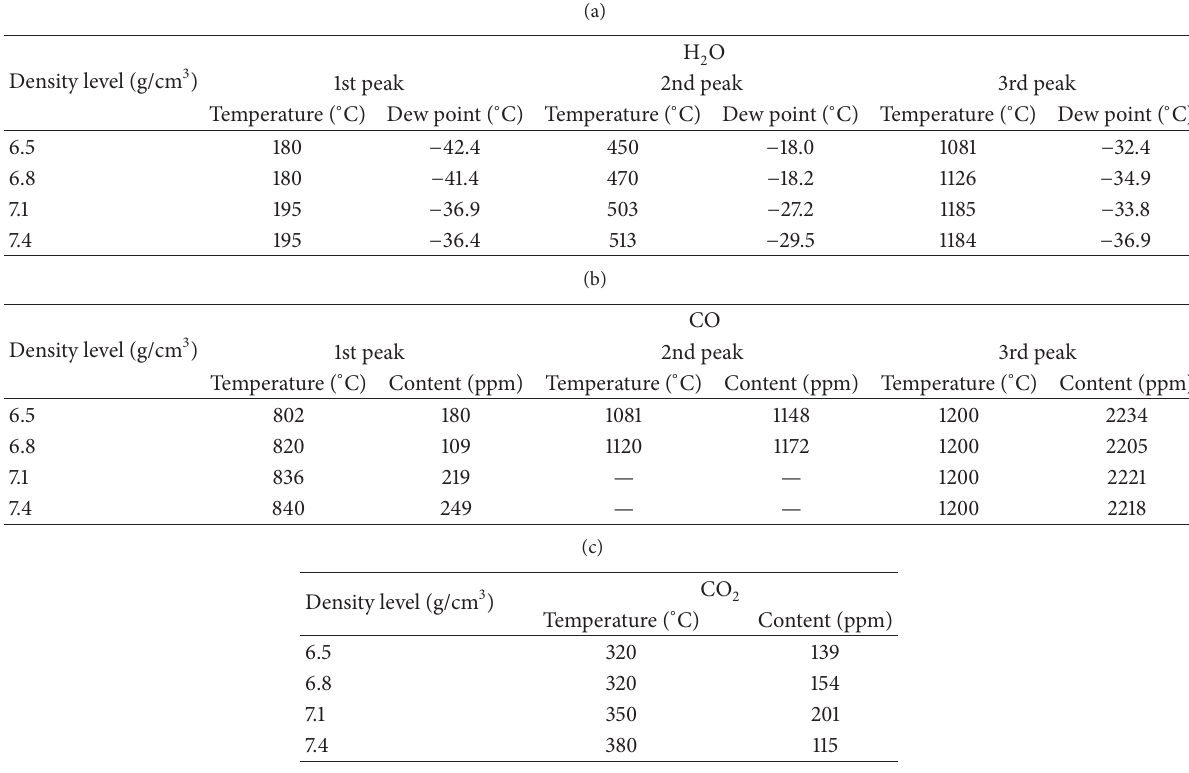
Table 2: (a) Effect of the component density on the temperature of the peaks on H in sampled gas. (b) Effect of the component density on the temperature of the peaks on CO profile and corresponding amounts of active constituent in sampled gas. (c) Effect of the component density on the temperature of the peaks on CO of active constituent in sampled gas.